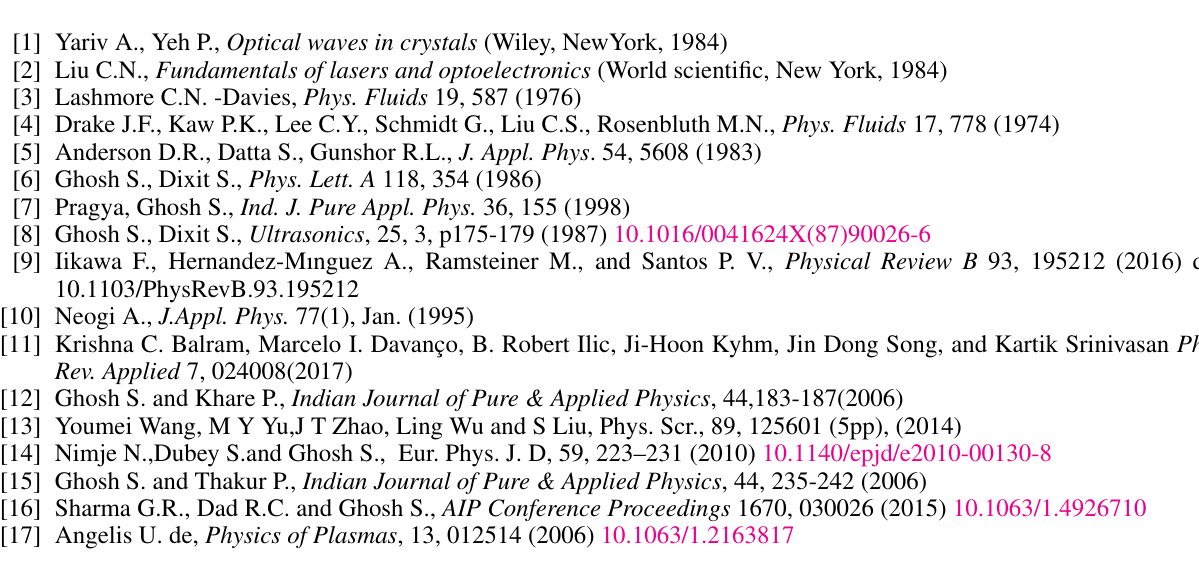
Fig. 4 Effective gain